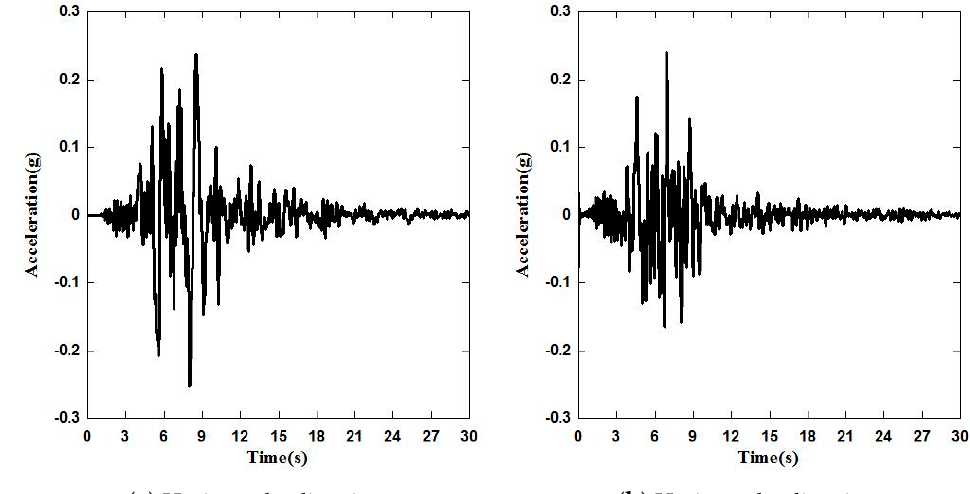
Figure 5. Time history of the Kobe earthquake.